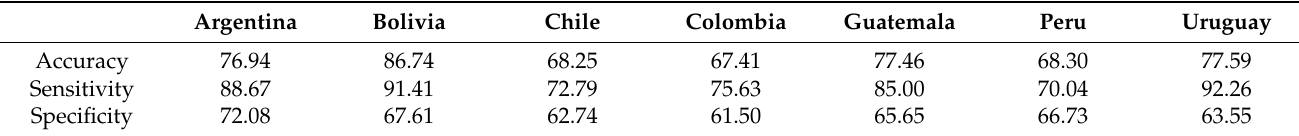
Table 5. Confusion matrix stage 3 CDM model, product